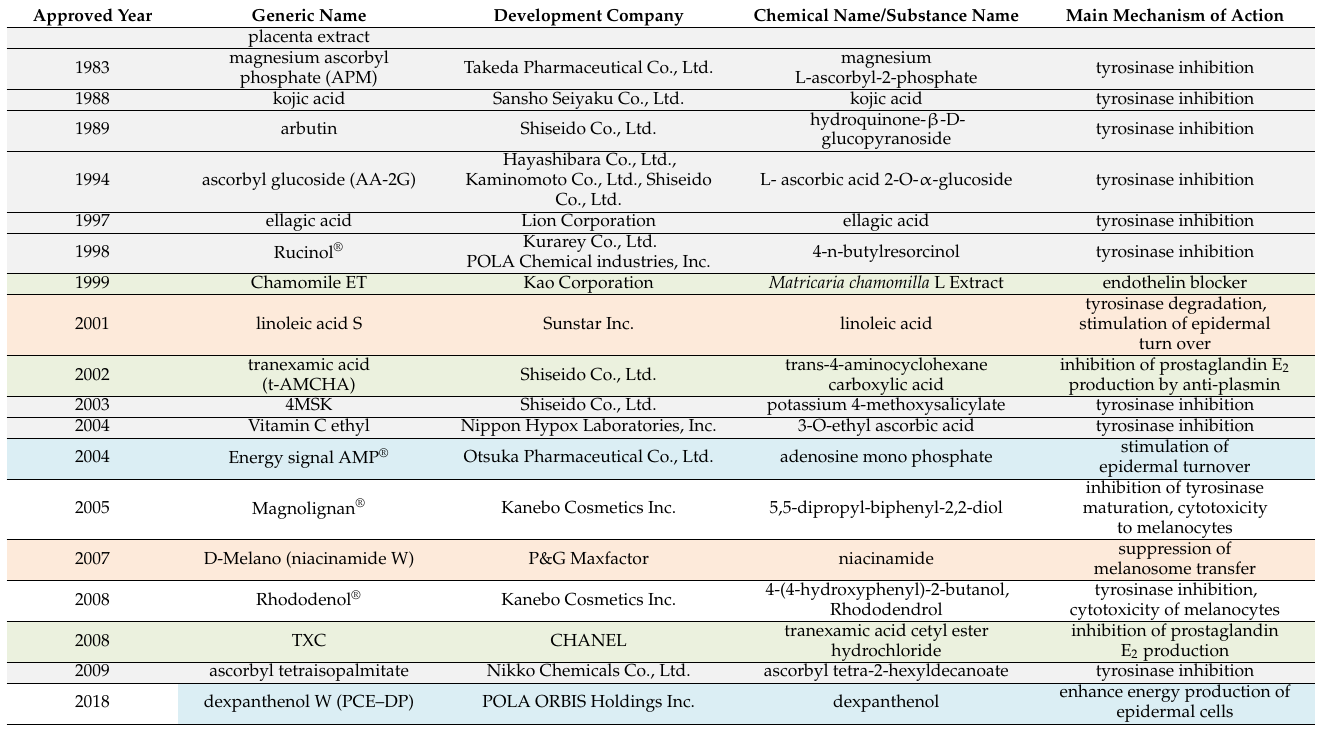
Table 1. List of skin-lightening active ingredients approved in